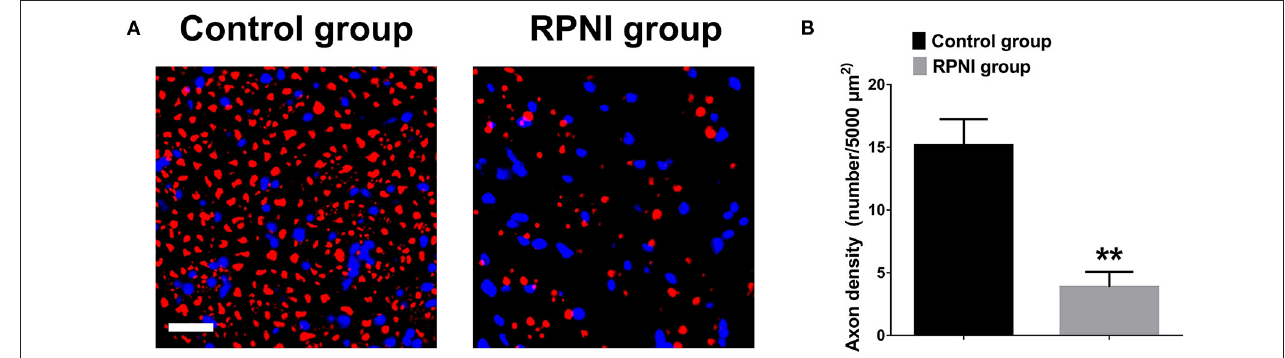
FIGURE 4 | Regenerative peripheral nerve interfaces (RPNI) significantly inhibited axonal regeneration after sciatic nerve transection. (A) NF200 immunofluorescence staining of cross sections of the proximal nerve stump. The fluorescence indicator used was Alexa Fluor 594 for NF200 (red). Nuclei are shown in blue. Scale bars: